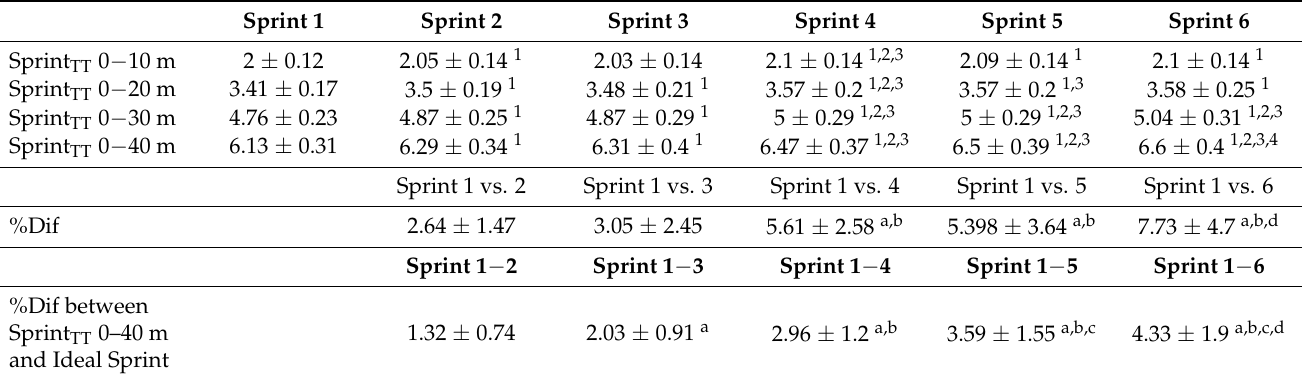
Table 3. Performance variables of the repeated sprint ability.